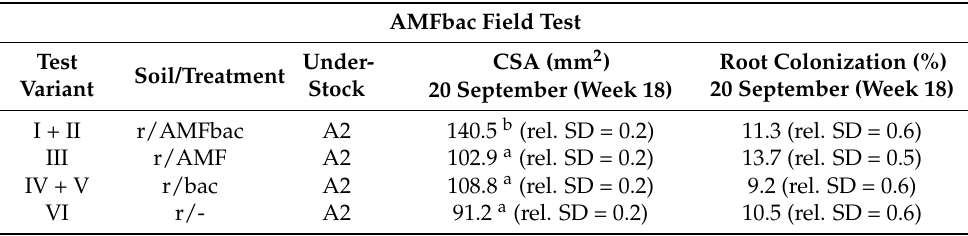
Table 11. AMFbac Field Test-Mean CSA (mm 2 ) and degree of mycorrhizal root